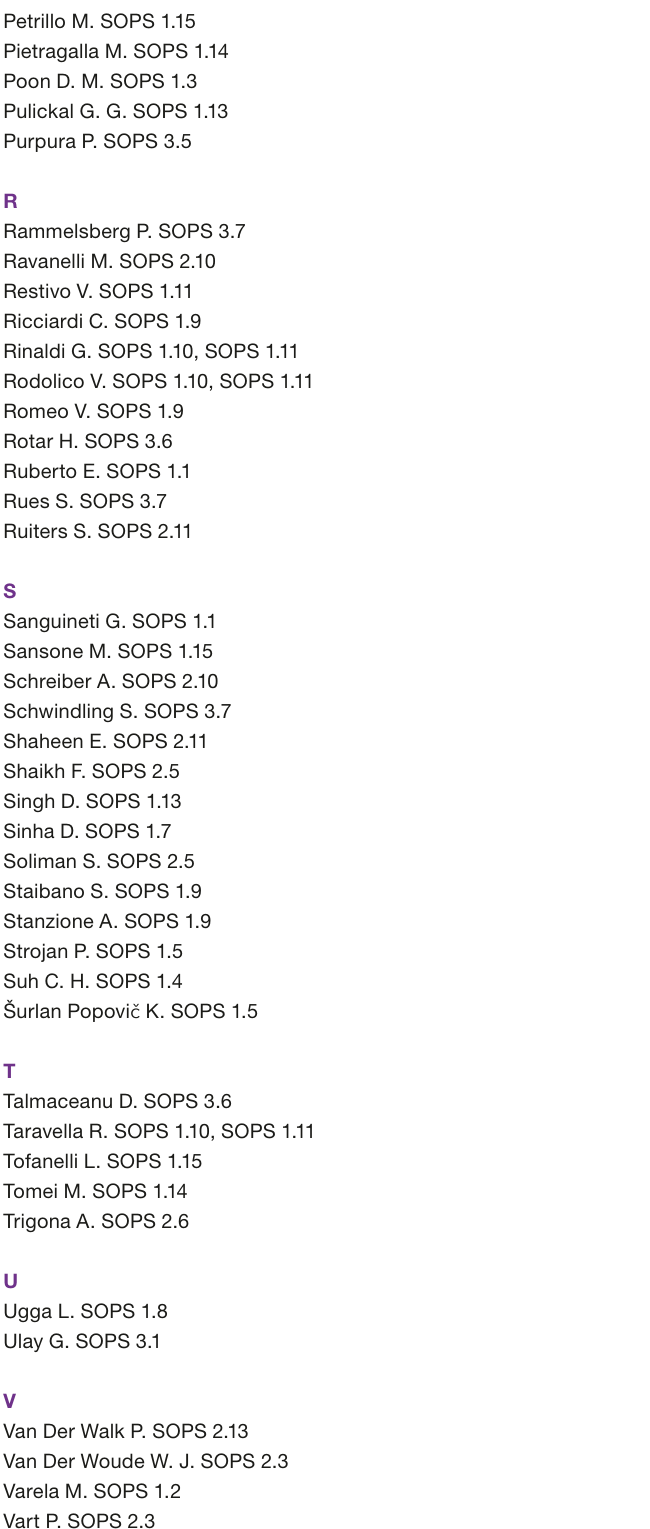
W Warne R. SOPS 2.8 Weber D. SOPS 3.7 Willaert R. SOPS 2.11 Z Zabret U. SOPS